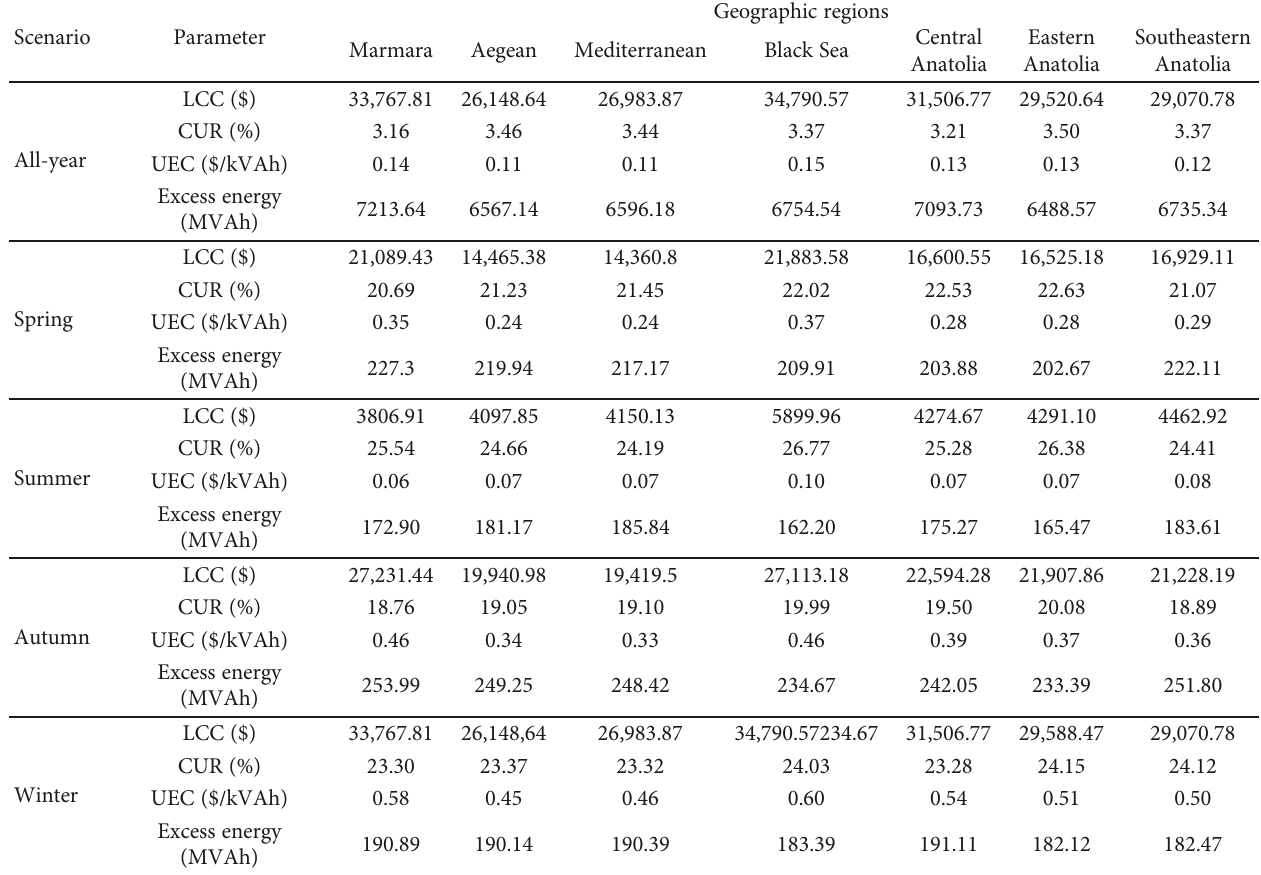
Table 5: Calculation results for all scenarios.